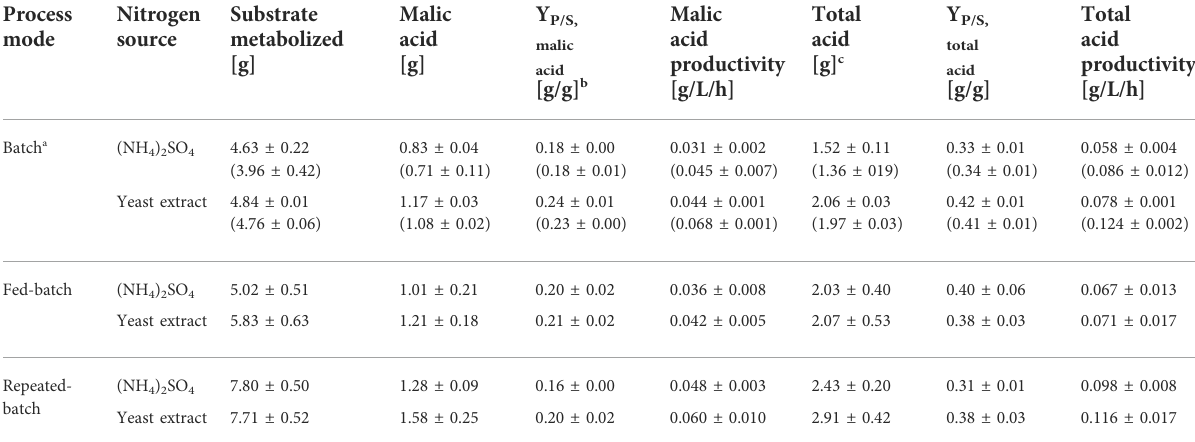
TABLE 4 Fermentation results for cultivations of A. oryzae using different process modes after 240 h. Values are means ± standard deviation, n = 3. Process